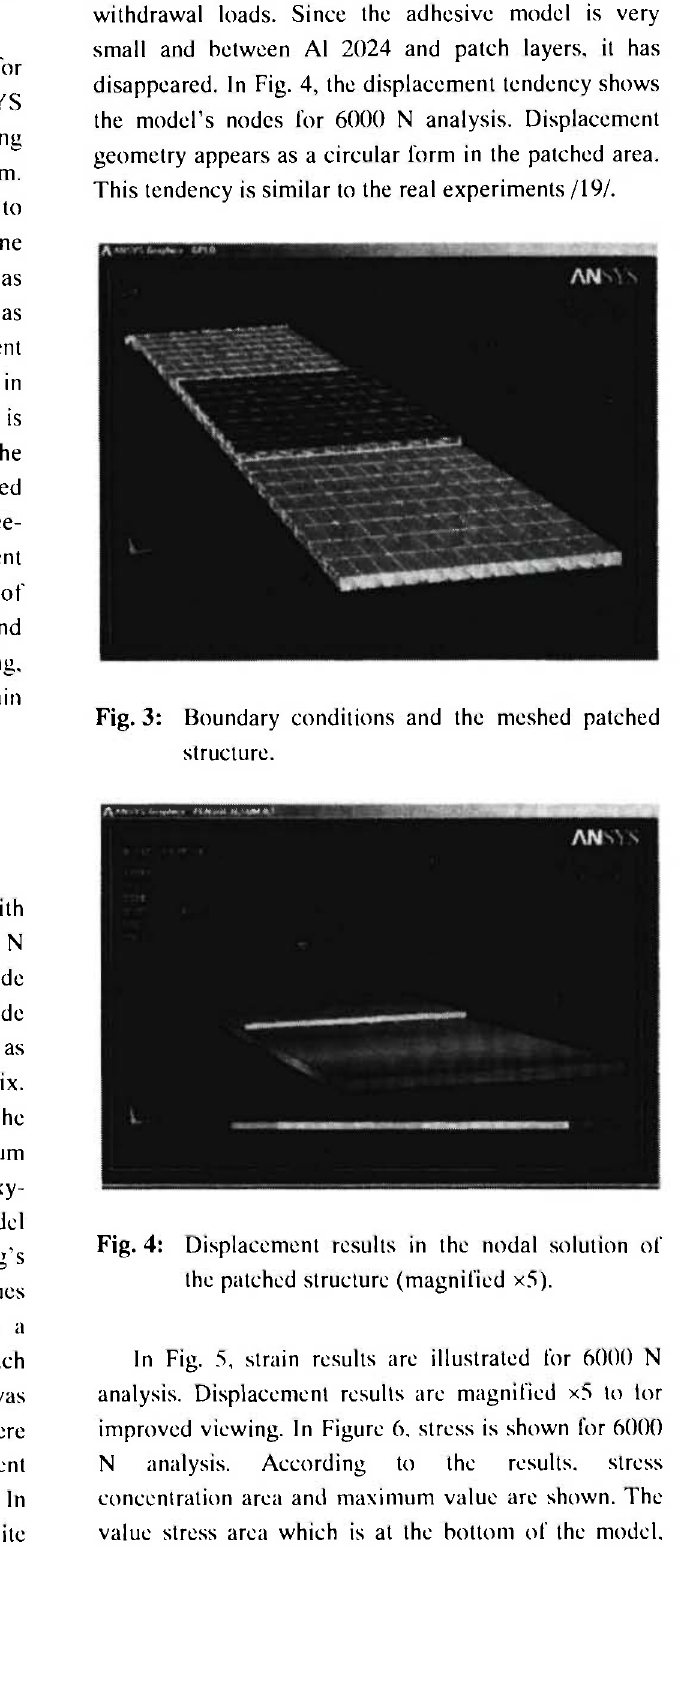
element model. In this figure, arrows represent withdrawal loads. Since the adhesive model is very